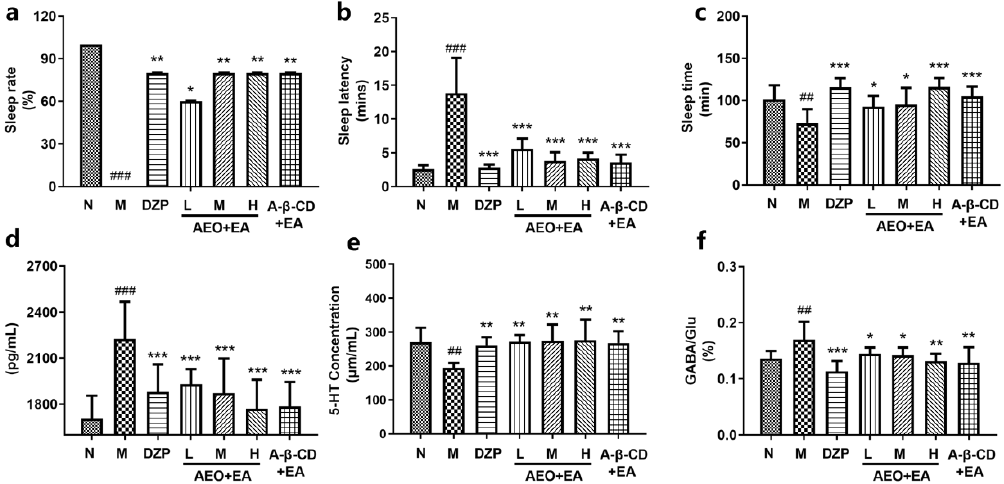
Figure 9. Effects of drugs on the sleep and experimental results of anti-insomnia pharmacody- namics. ( a ) The effect on the sleep rate, ( b ) the effect on sleep latency, ( c ) the effect on sleep time, ( d ) the concentration of NE, ( e ) the concentration of 5-HT, and ( f ) percentage of the ratio of GABA to Glu. The level of significance was set at # p < 0.05, ## p < 0.01 and ### p < 0.001, compared to the normal group; * p < 0.05, ** p < 0.01 and *** p < 0.001 compared to the model group. Data were presented as mean ± SD ( n = 6).